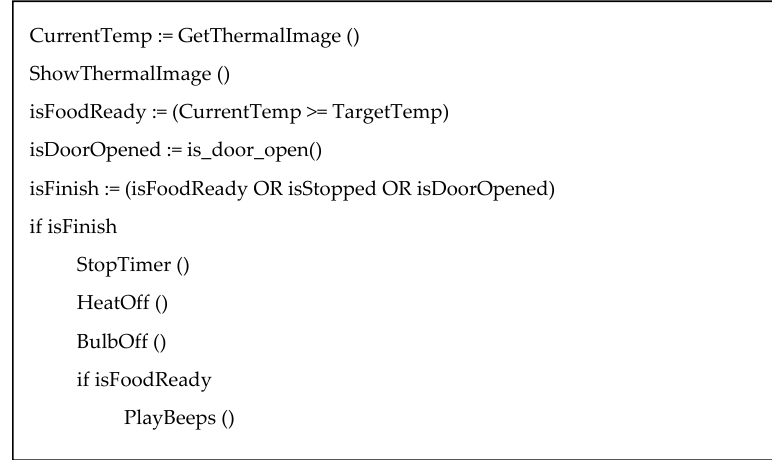
Figure 7. Pseudocode for the timer event callback function during heating.